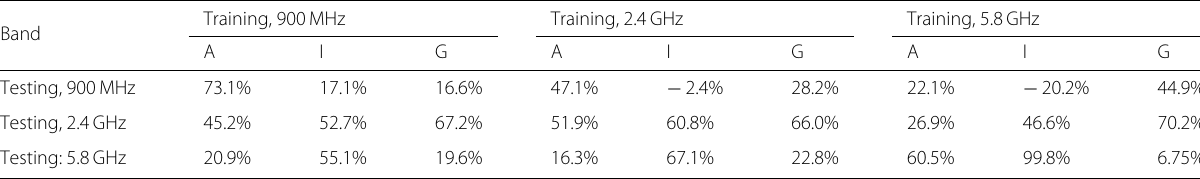
Table 7 Training across frequency bands: (A)ccuracy is percentage of time classification chooses ideal rate, (I)mprovement is its throughput gain over a SNR-based method, and (G)ap is its throughput percentage from the maximum